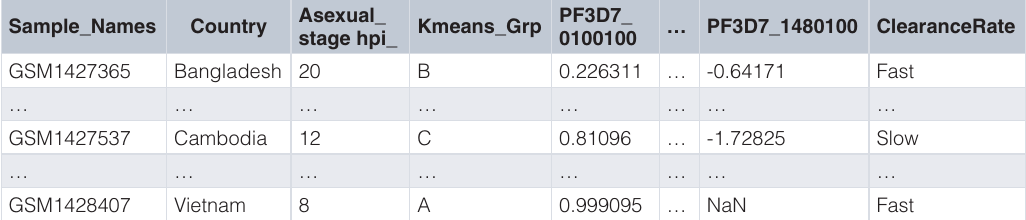
ensemble model. 50